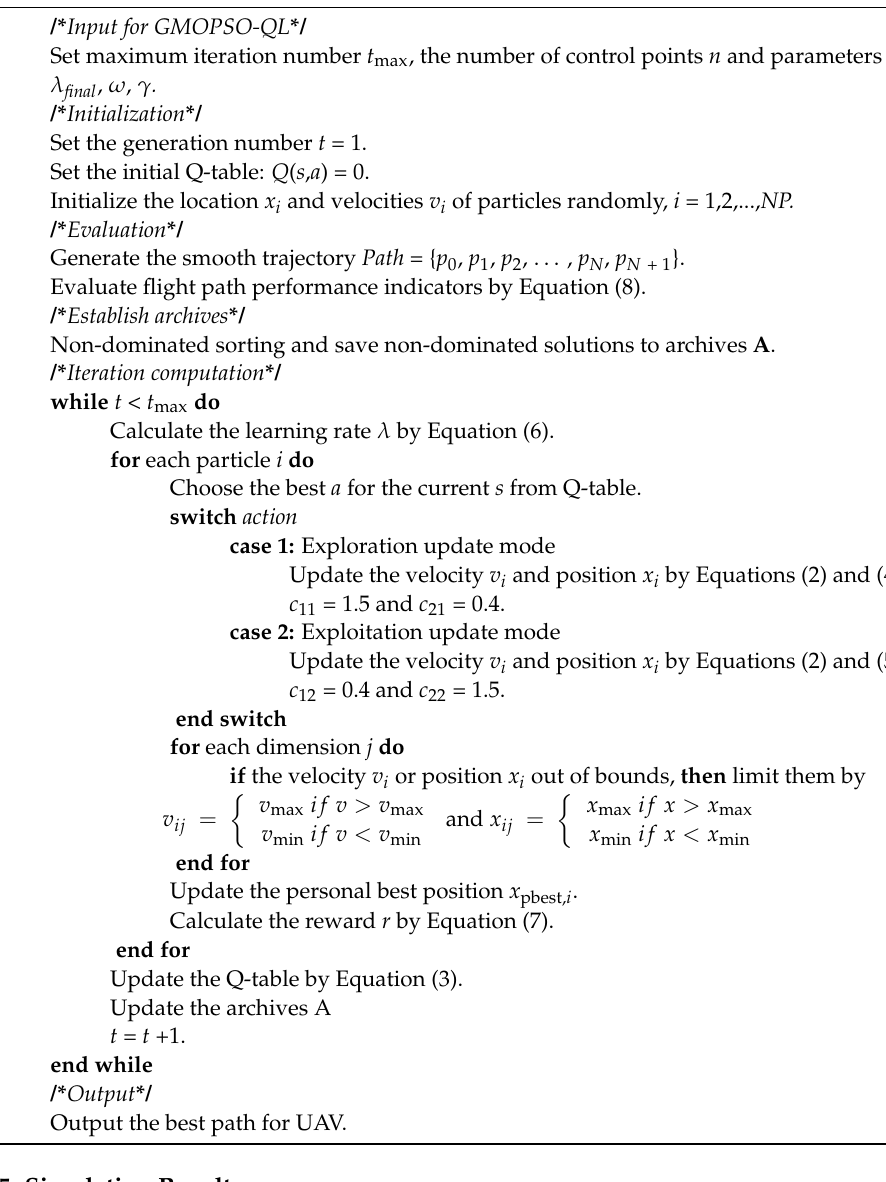
Algorithm 3. GMOPSO-QL based path